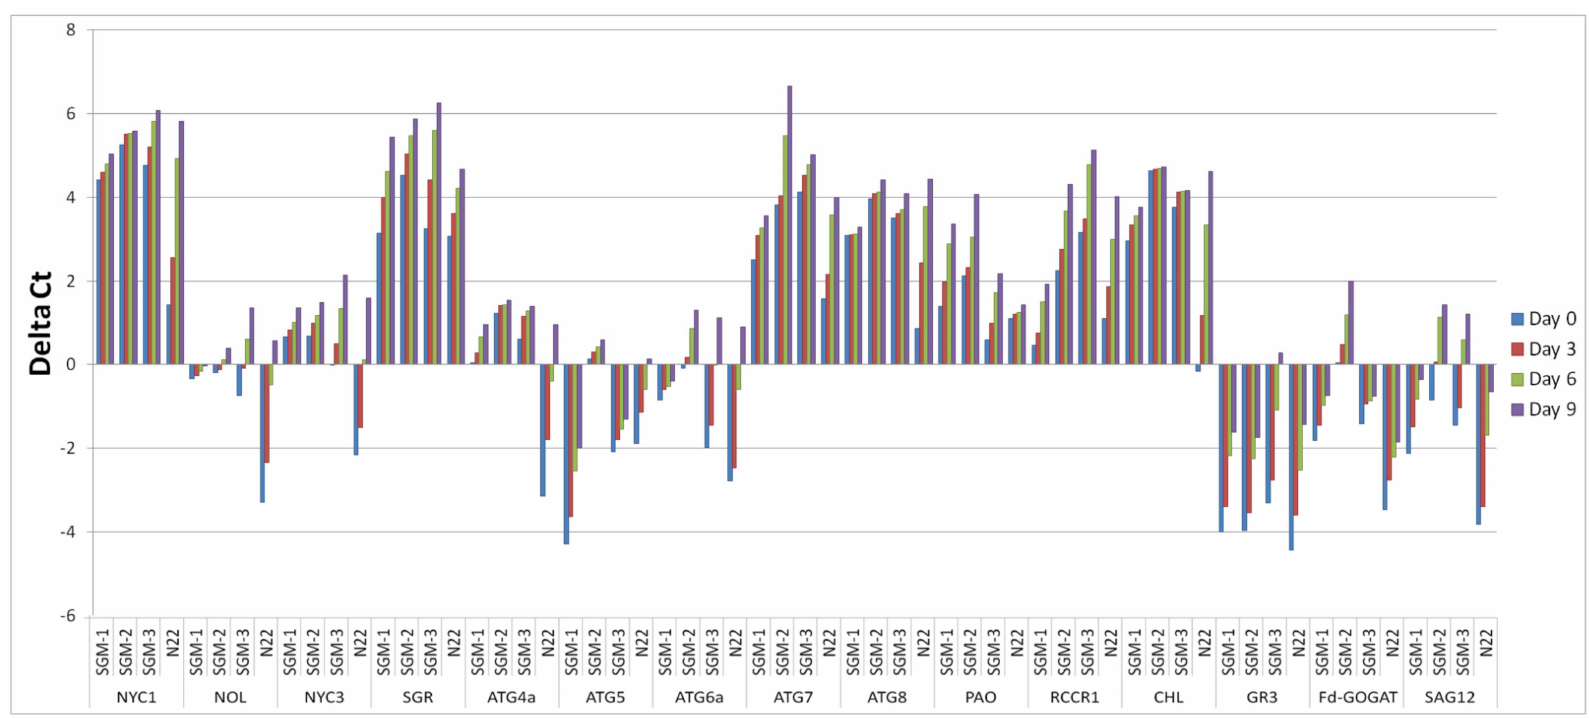
Figure 3. Time-course relative gene expression analysis of 15 genes involved in chlorophyll catabolism, senescence and nitrogen assimilation in three stay-green mutants (SGM-1 to SGM-3) and the wild type, Nagina 22 (N22) under dark